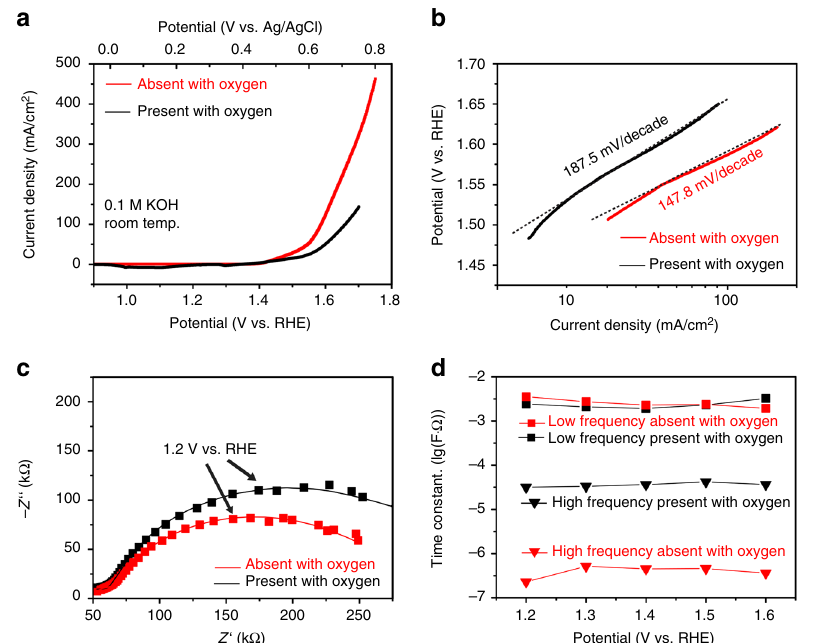
Fig. 2 OER activity of Ni-graphene nanosheet-based device. a Oxygen evolution currents of Ni-graphene nanosheet measured in 0.1 M KOH. b Tafel plots of OER currents in a . c The Nyquist plots in the potential at 1.2 V vs. RHE together with the responding fi tted curve based on the equivalent circuit model. d Plot of the high- and low-frequency time